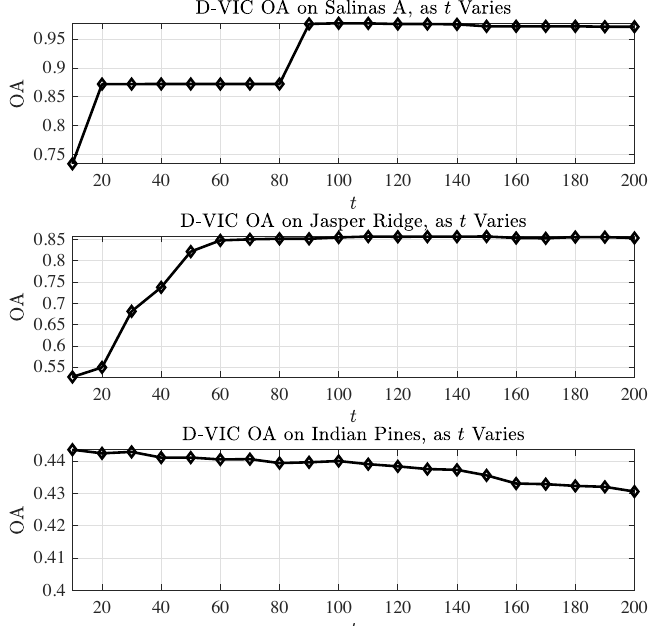
Figure 9. Analysis of D-VIC’s performance as t varies across [ 10,200 ] . Values are the median OA across 100 implementations of D-VIC with the optimal N and σ 0 values. Generally, t appears to have little impact on the OA of D-VIC, and D-VIC achieves performances comparable to those reported in Table 2 across t ∈ [ 90,200 ] , uniformly across all data